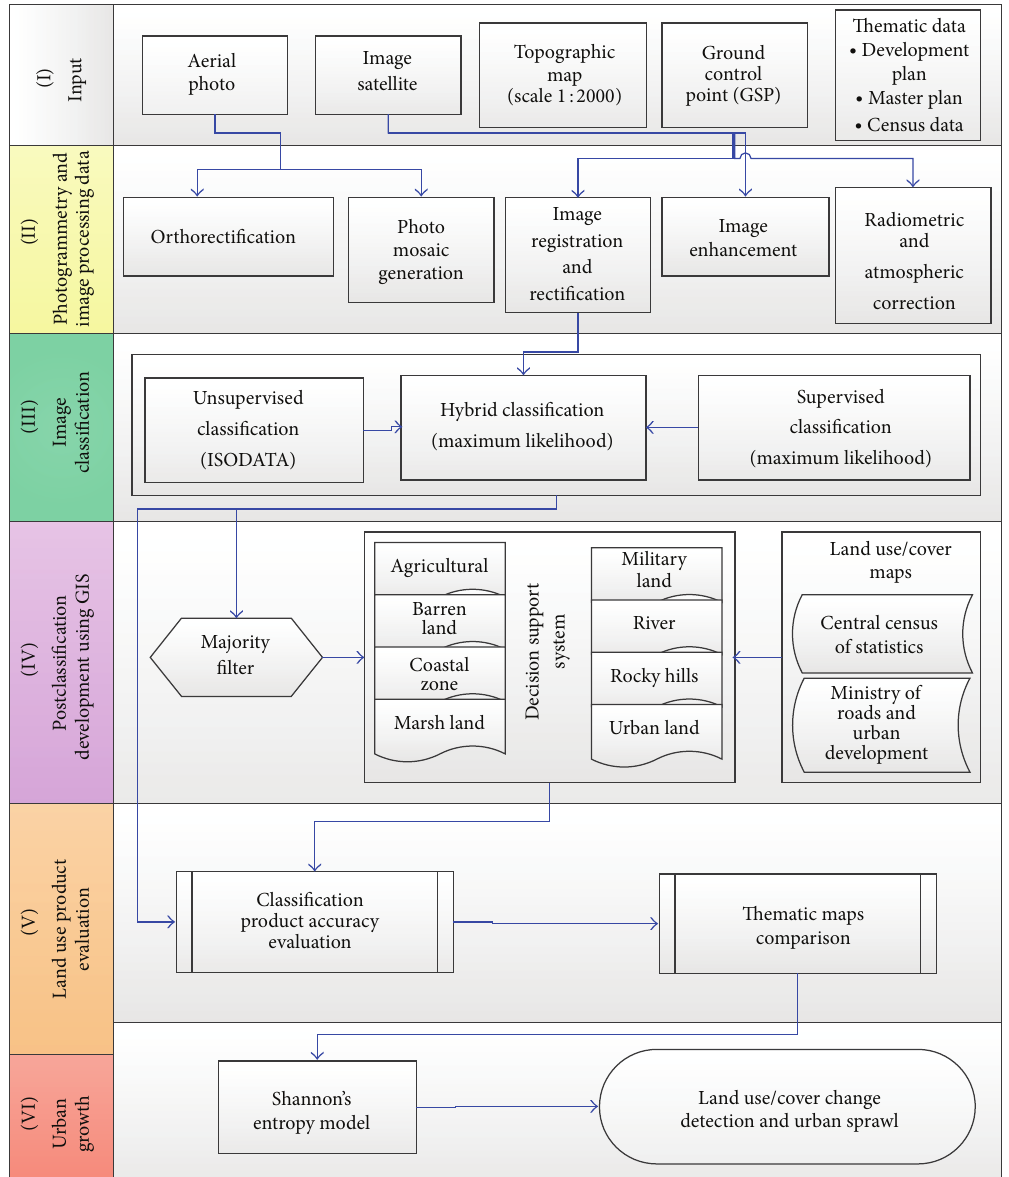
Figure 2: Methodology of detecting trend of land use/cover changes (LULC) in Bandar Abbas city.